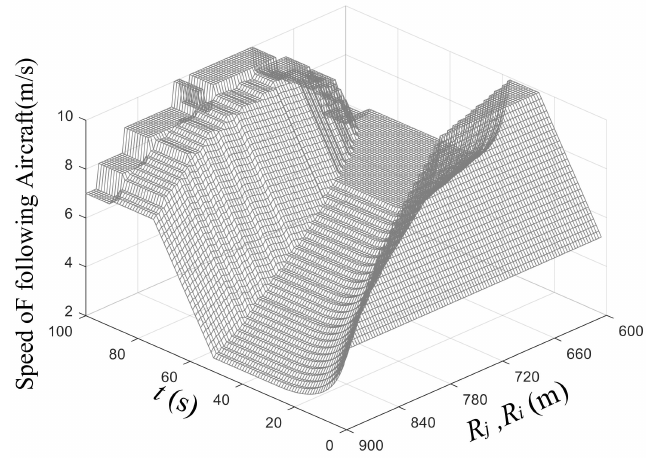
Figure 4. Trend Chart of Following aircraft’s Speed with Time and Visual Range.